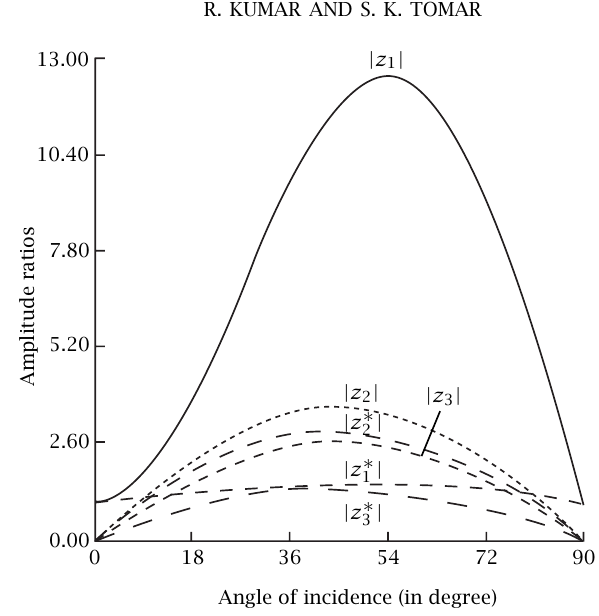
Figure 4.1 . Variation of amplitude ratios with angle of incidence of longi- tudinal wave.